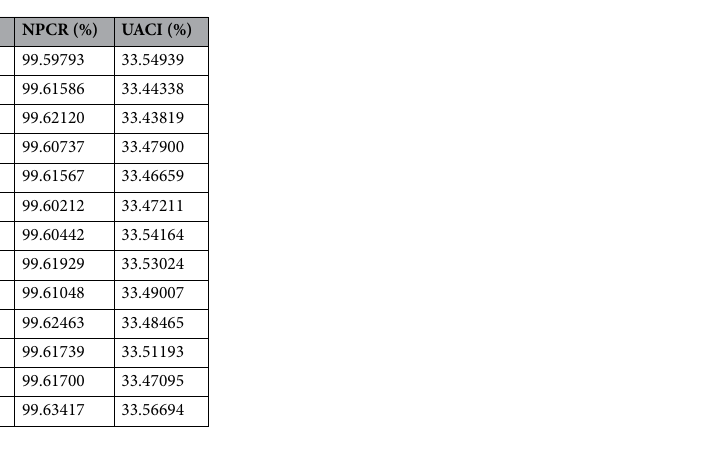
Table 1. NPCR and UACI performance of ciphered